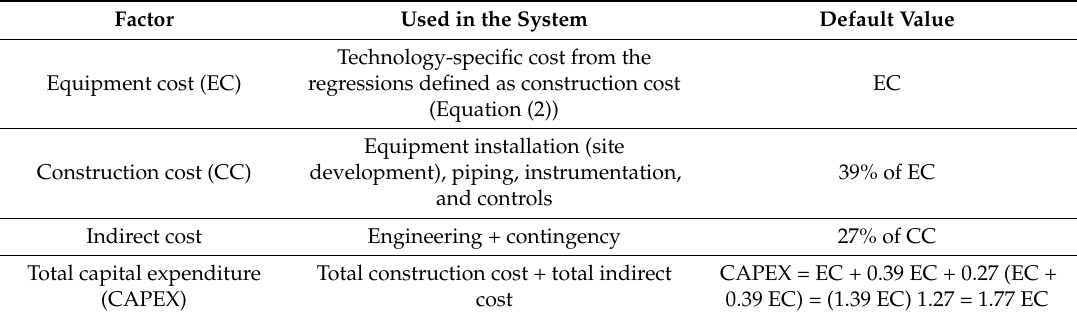
Table 8. Standard capital cost algorithm applied (adapted from